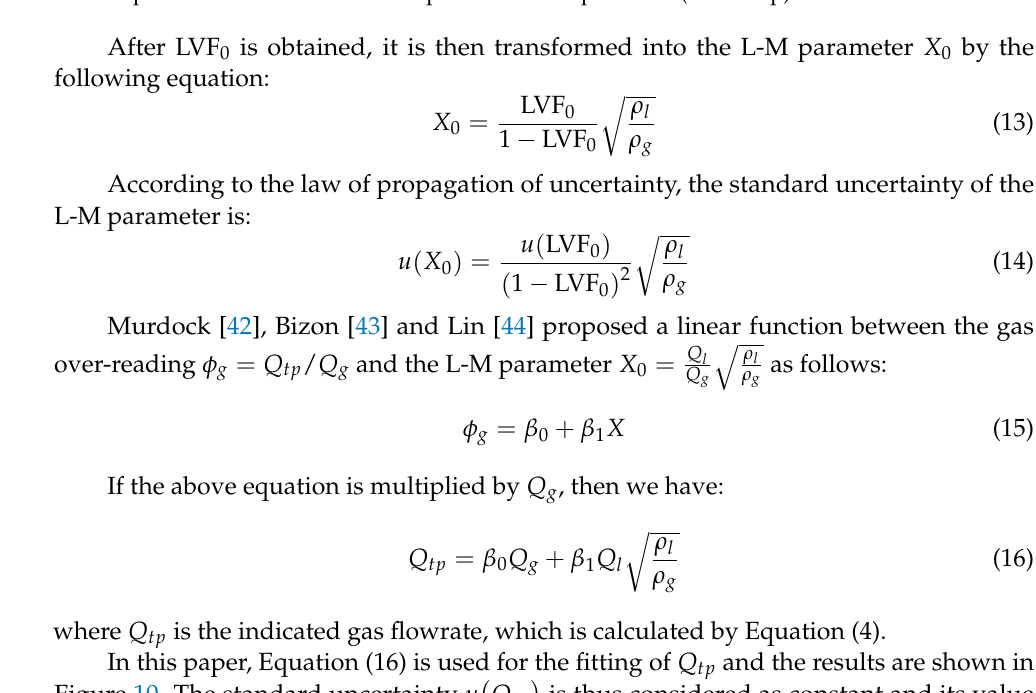
can be calculated by Equation (A5). The coefficient ˆ β and covariance matrix Σ ˆ calculated by Equations (A3) and (A4) respectively. These parameters will be used later